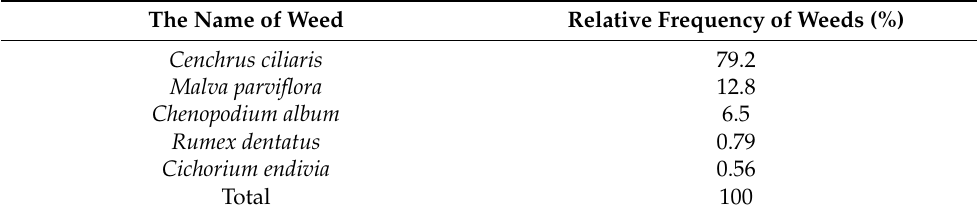
Table 2. Dominant annual weed species and their density (% m 2 ). The Name of